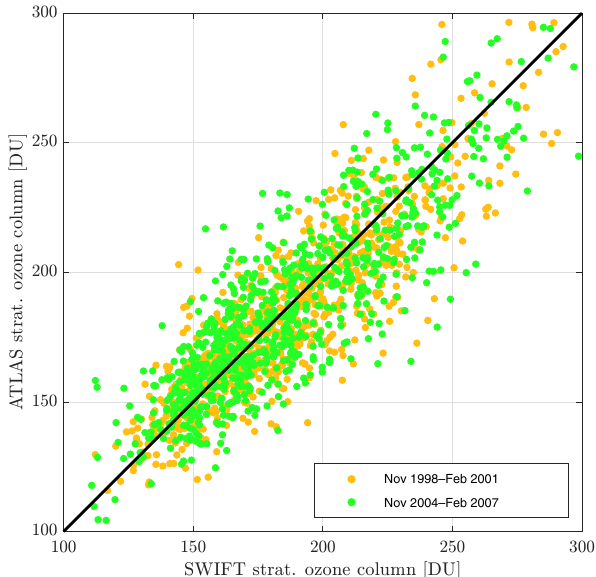
Figure 9. SWIFT vs. Aura MLS scatter plot of daily averaged stratospheric ozone columns (15–32km) over Potsdam. The green dots correspond to the second training data period, and the pink dots correspond to the pink period in Fig.